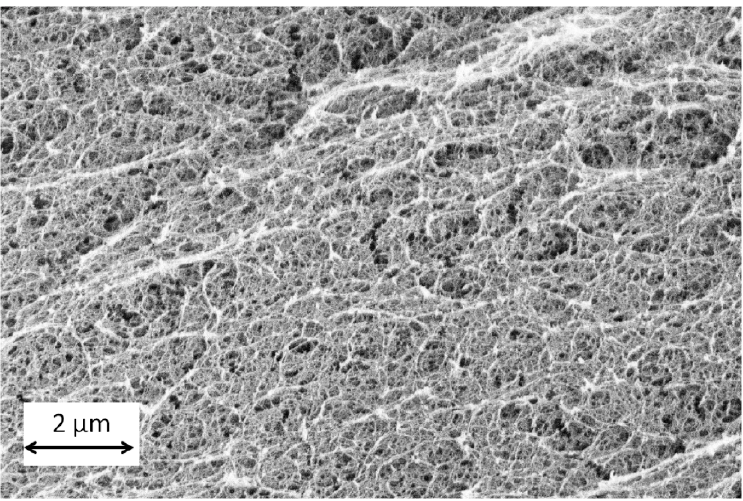
Figure 9. Comparison of equilibrium uptake ( q e ) and initial sorption rates ( h ) for ethanol (( a ) and ( b )) and DMSO (( c ) and ( d )) for various alginate concentration and crosslinking degree. The applied concentration gradient is 30 wt %. Please refer the supplementary tables (Tables S5 to S10) for q e , k 2 and h values.